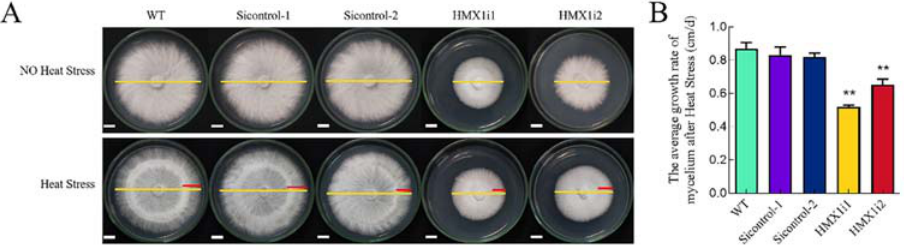
Figure 2. Comparison of mycelial growth under heat stress. ( A ) Under the circumstance of non-heat stress or heat stress, the growth of WT, Si-control, and HMX1 silenced strains in 5 days. The yellow line is the diameter of the mycelium after 7 days of growth on plate; after 5 days of mycelium growth on plate, the red line is the distance that the mycelium recovered for 2 days after heat shock at 42 ◦ C for 30 min. The white line is the scale bar, scale bar = 1 cm. ( B ) The average mycelium growth rates of WT, Si-control, and HMXli strains 2 days after heat shock, respectively. Error bars are represented as mean ± SEM. Significance was accepted at ** p < 0.01. The same as